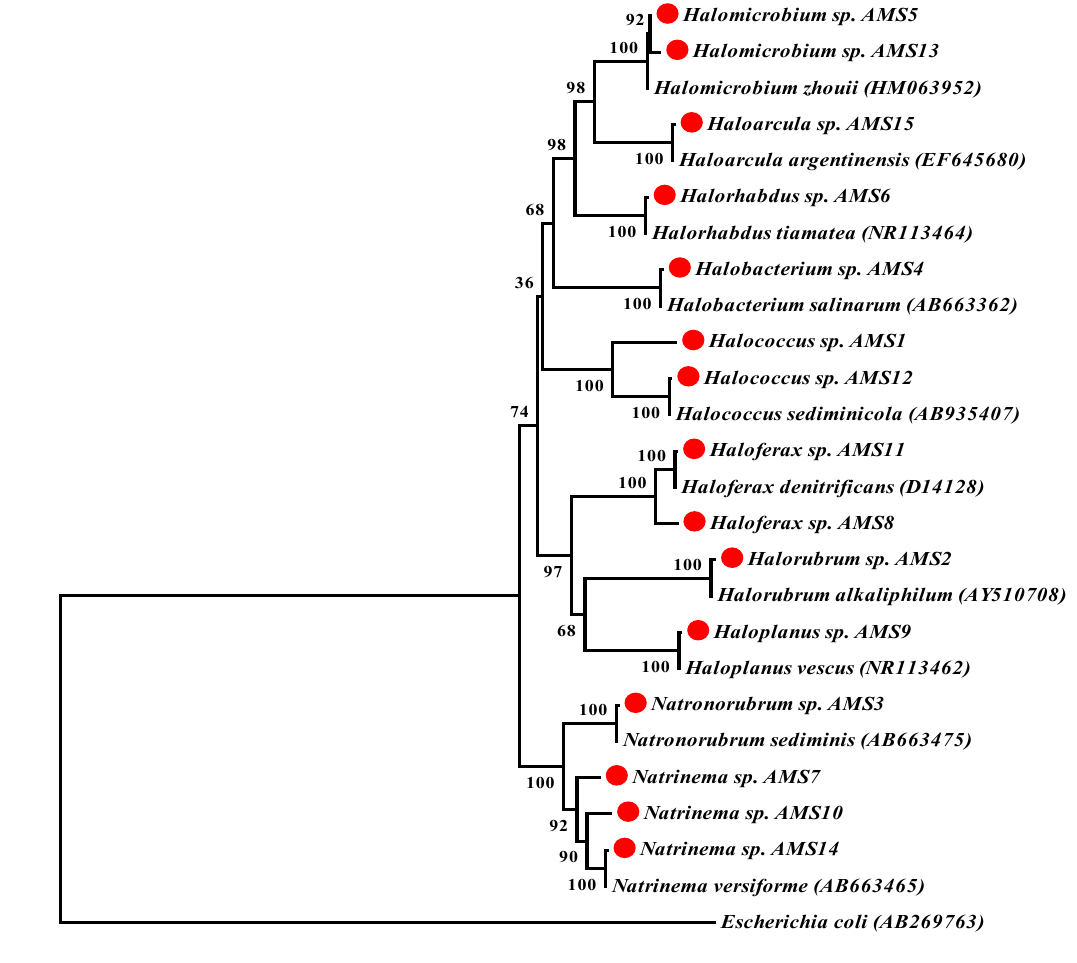
Figure 3. Phylogenetic analysis of EPS-producing marine archaeal from sediment sample.